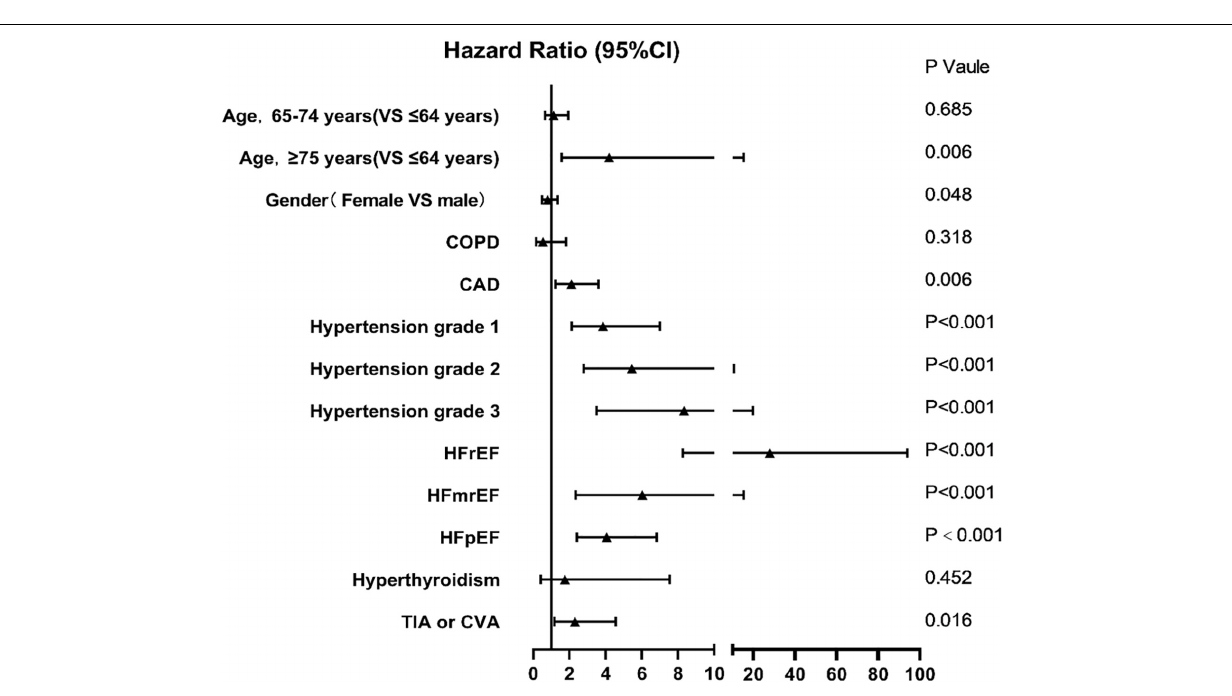
FIGURE 4 | Hazard Ratio for the outcome and its risk factors in C2HEST and HATCH